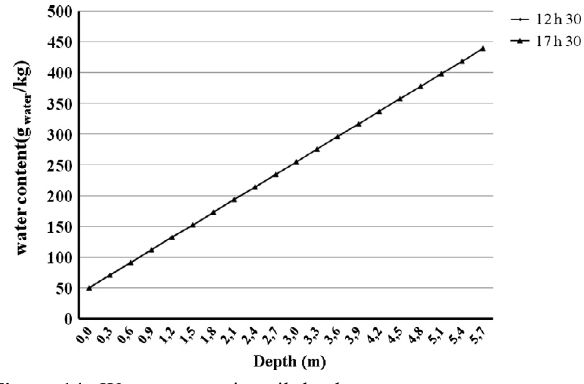
Figure 14. Water content in soil